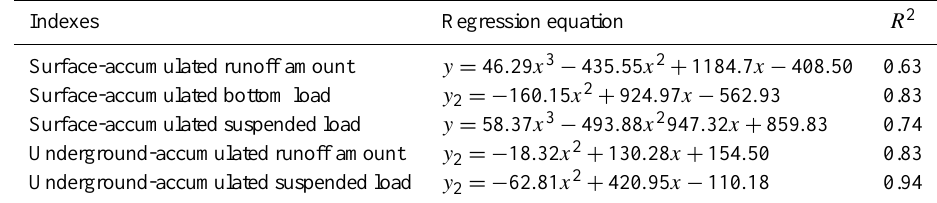
Table 9. Regression equation of accumulated runoff and sediment production and rock bareness ratio ( x